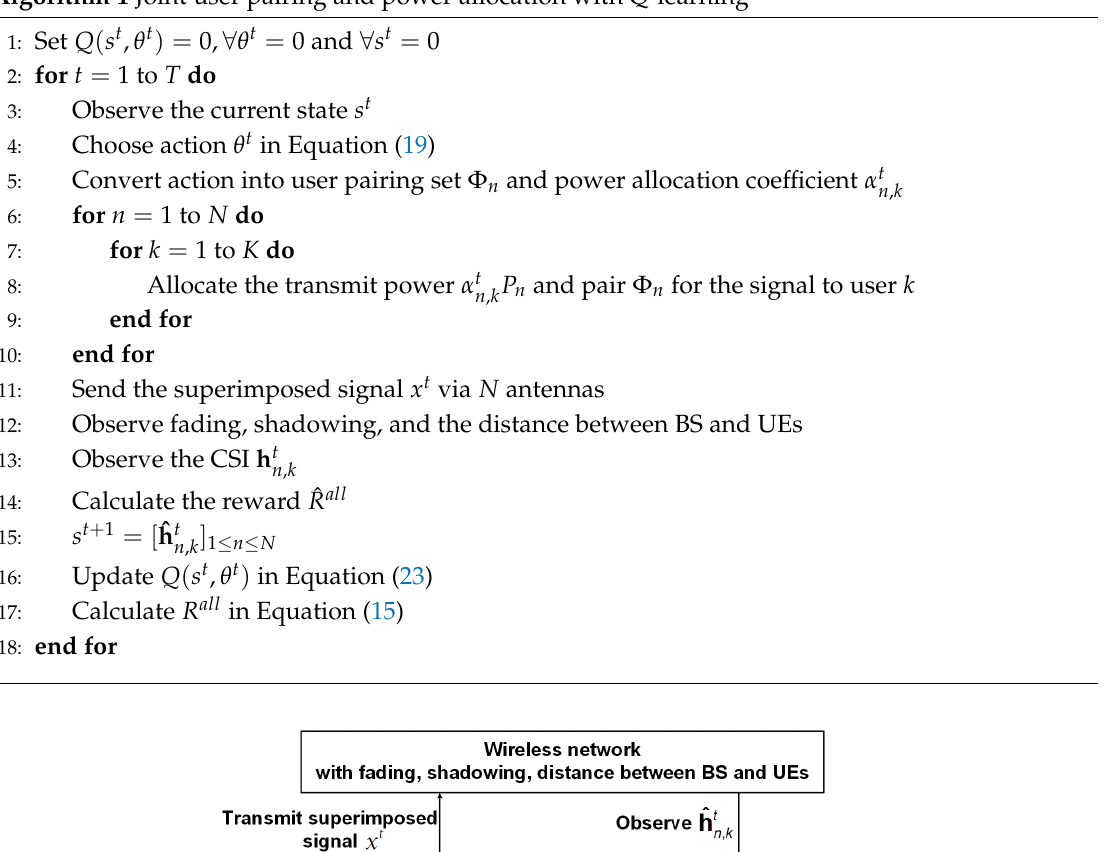
Algorithm 1 Joint user pairing and power allocation with Q-learning